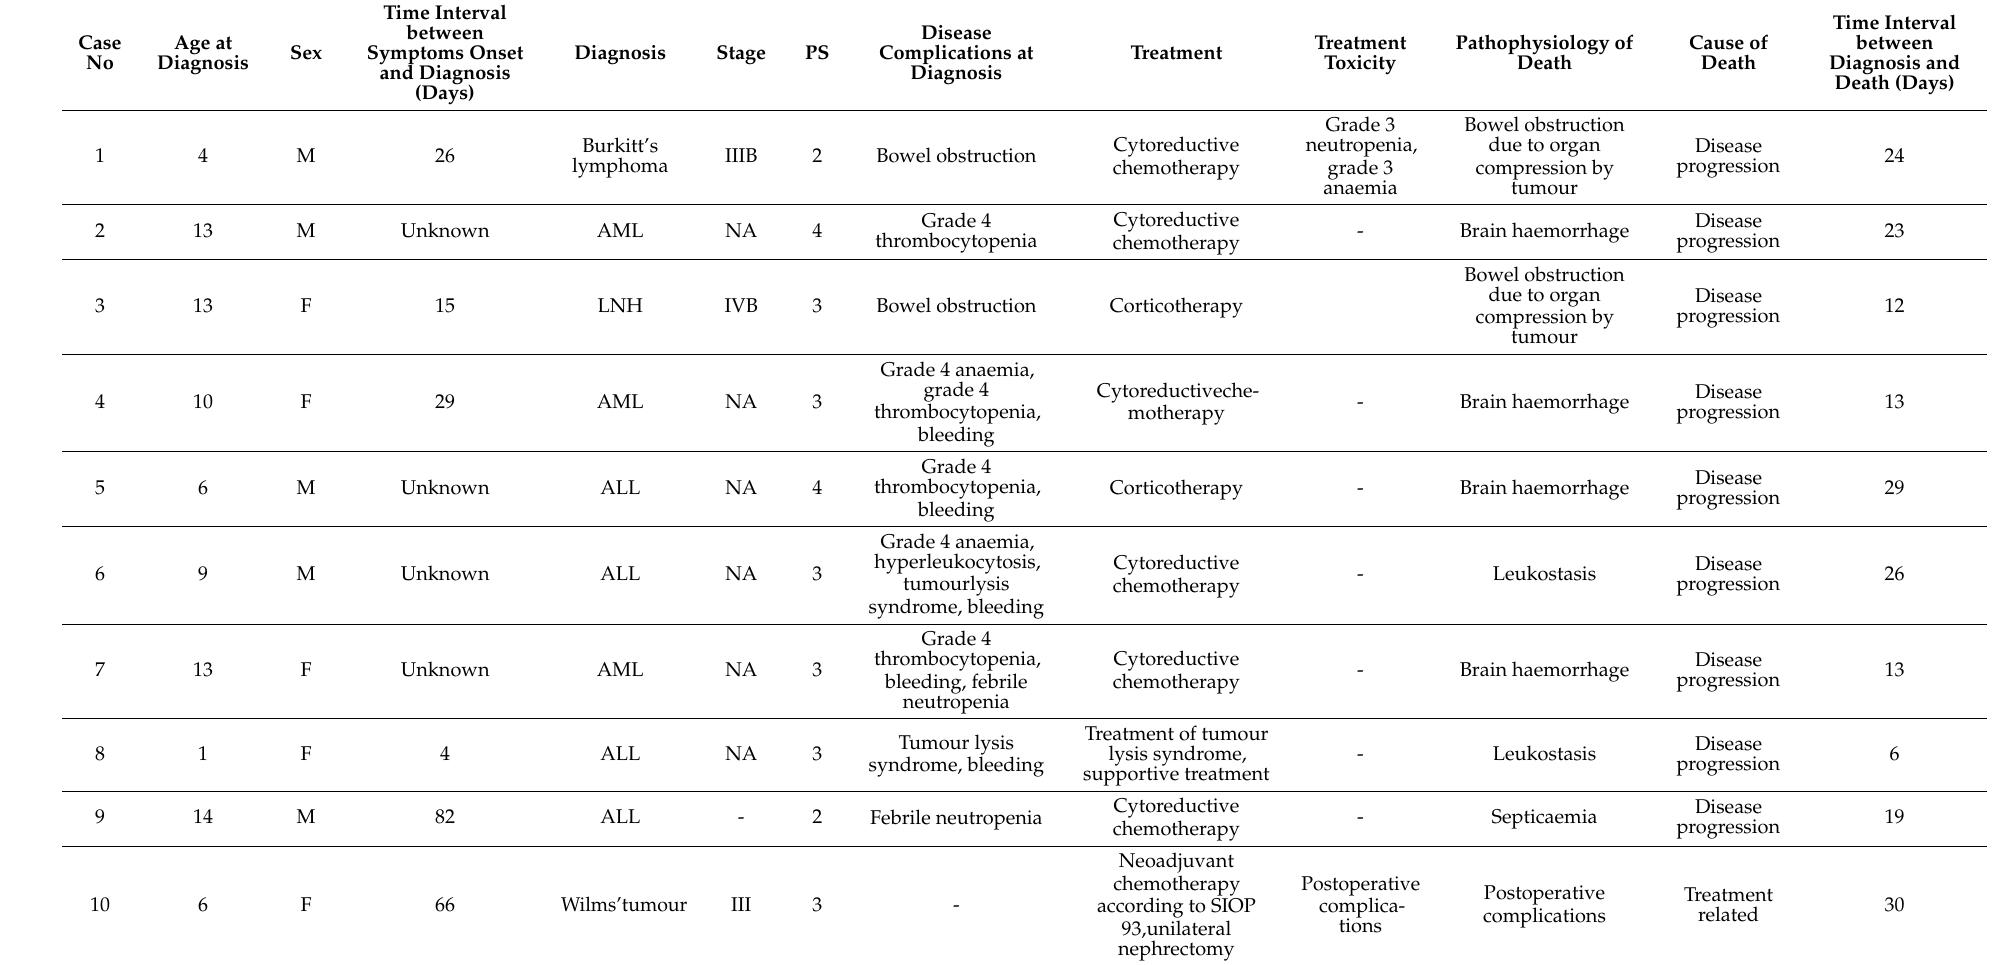
Table 5. Clinical characteristics of patients included in the early death